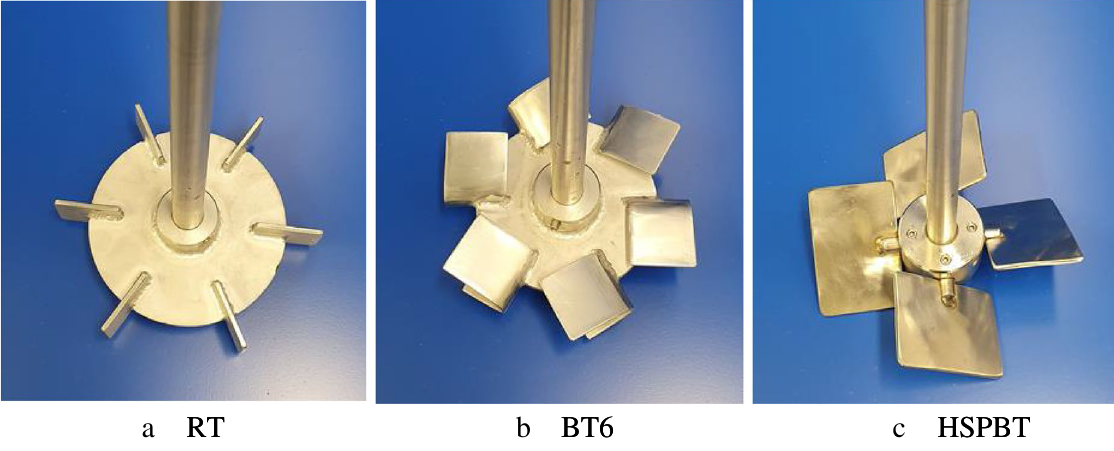
Fig. 2 Impeller combinations used in experiments. RT Rushton turbine, BT6 Bakker turbine, HSPBT high solidity pitched blade turbine (Blade dimensions (length and width) = l b and w b (10 −2 m): RT—3 × 4; BT6—3 × 5; HSPBT—5 ×